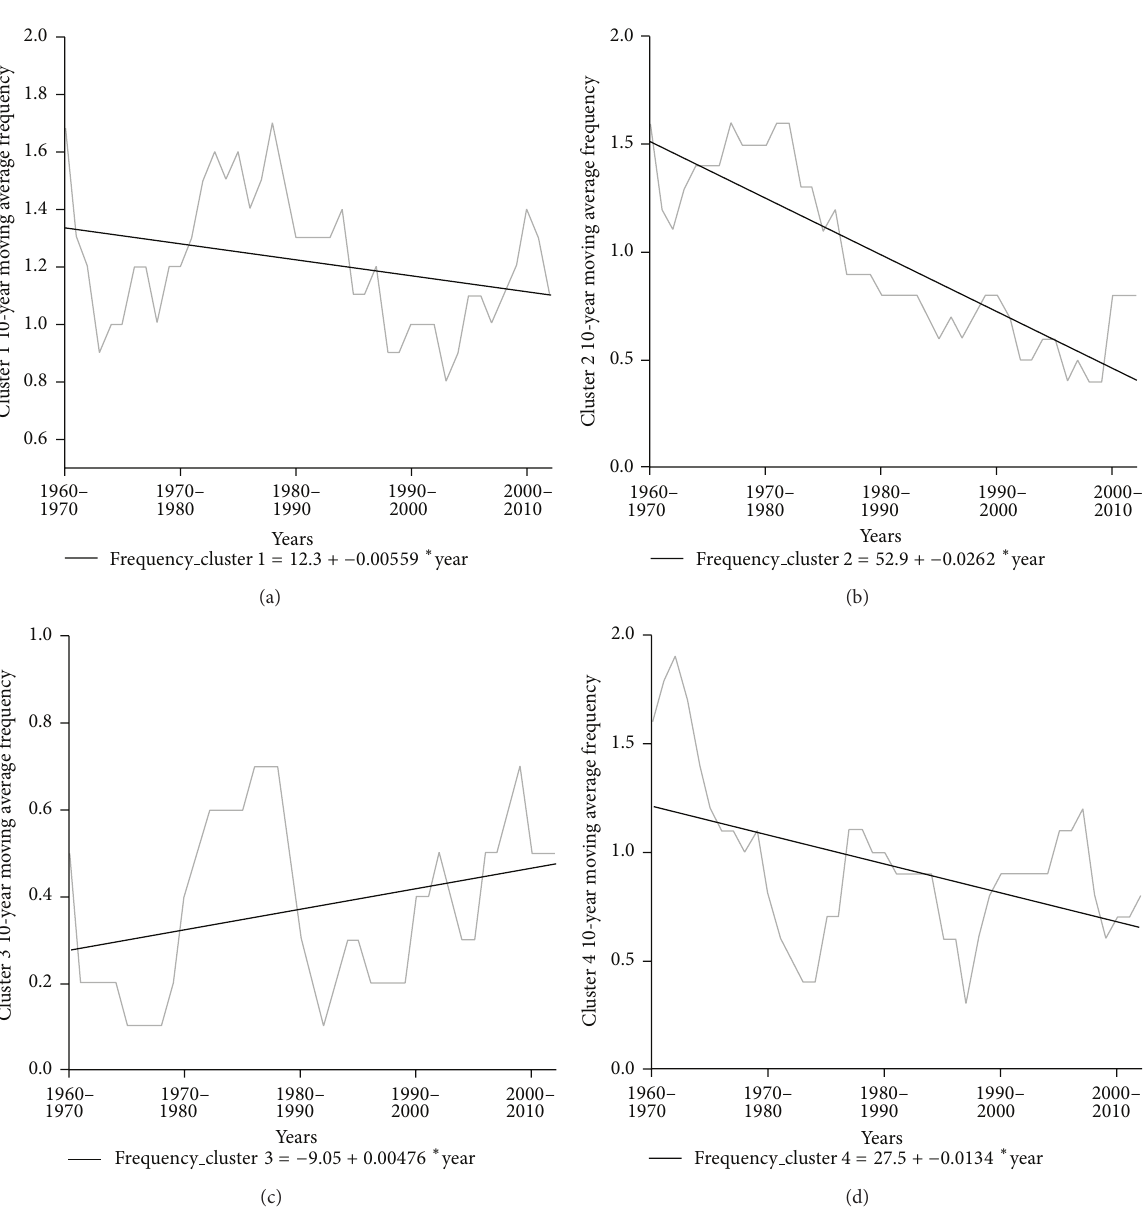
Figure 9: Ten-year moving average frequency of snow events. Cluster 1 (a), cluster 2 (b), cluster 3 (c), and cluster 4